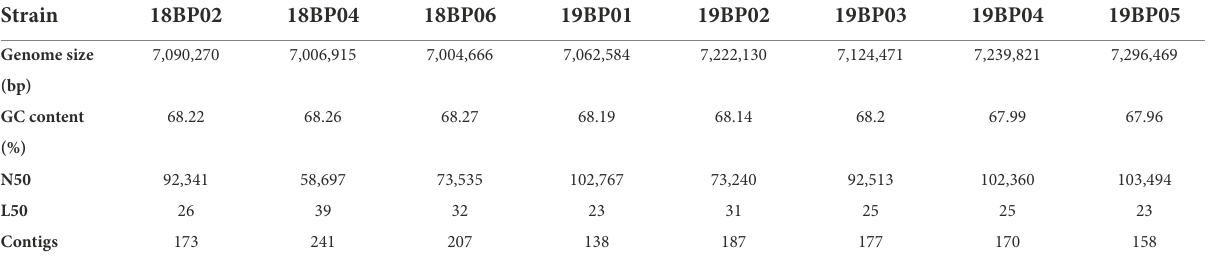
TABLE 3 Genomic features of the eight B. pseudomallei draft genomes.